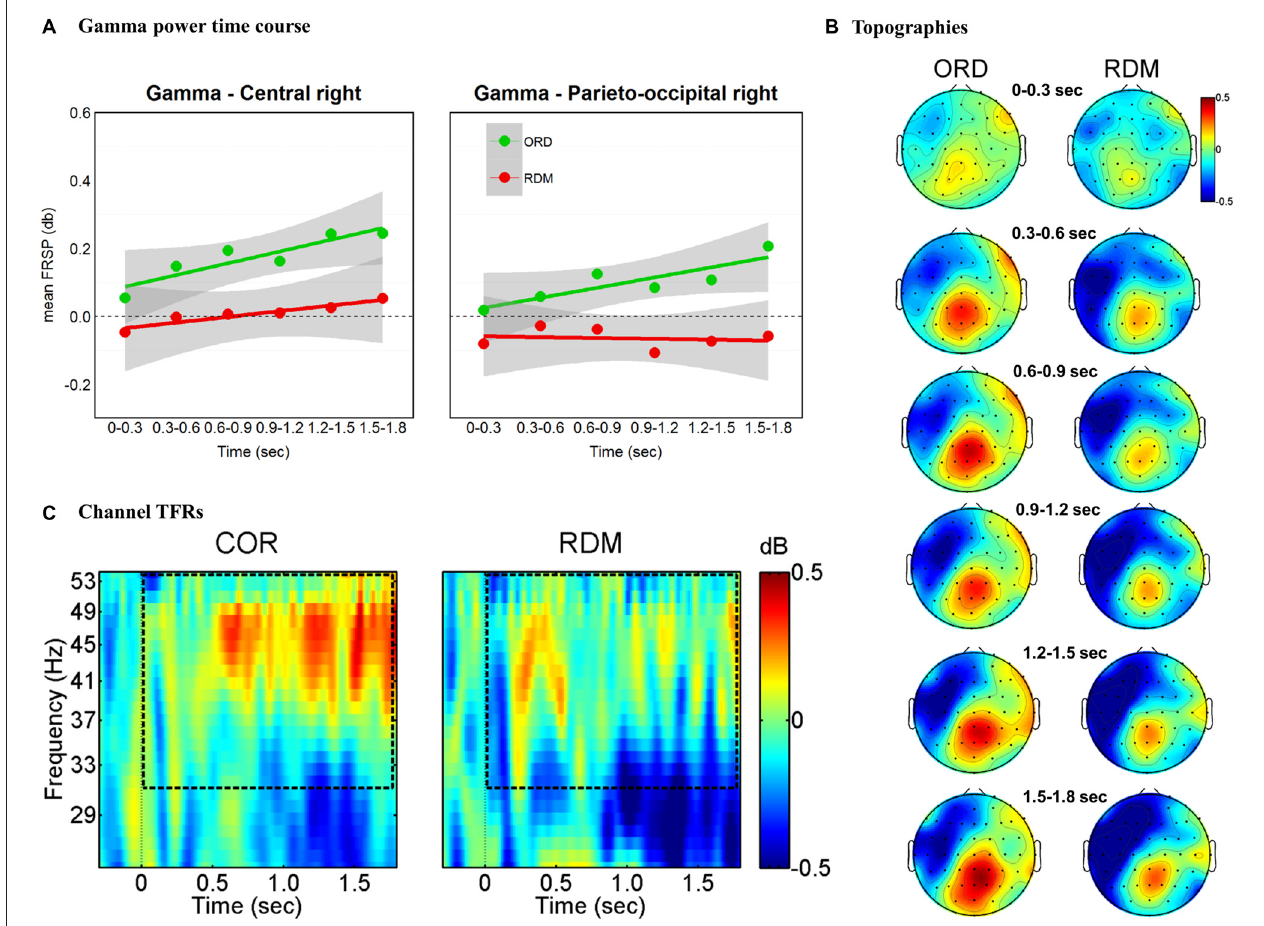
FIGURE 4 | Gamma band (31–55 Hz) effects time-locked to sentence onsets. (A) Time course of gamma power for right parieto-occipital and central clusters. Mean power values are plotted in successive 300 ms time windows, up to 1800 ms. We fitted a linear regression line for each condition (green and red lines). The shaded gray regions represent a pointwise 95% confidence interval. (B) Topographic maps of gamma (31–55 Hz) power change in successive 300 ms time windows, up to 1800 ms. (C) TF representations of power changes at the sentence-level analysis. The black rectangles indicate the frequency range of interest. Results are plotted at one representative channel